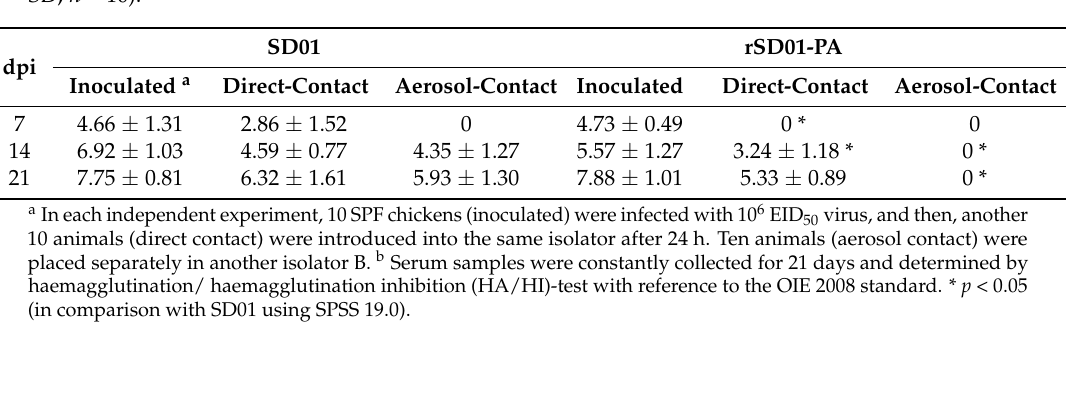
Table 4. Results of antibody titers of the serum of SPF chickens in the transmission experiment (log2 ± SD, n =